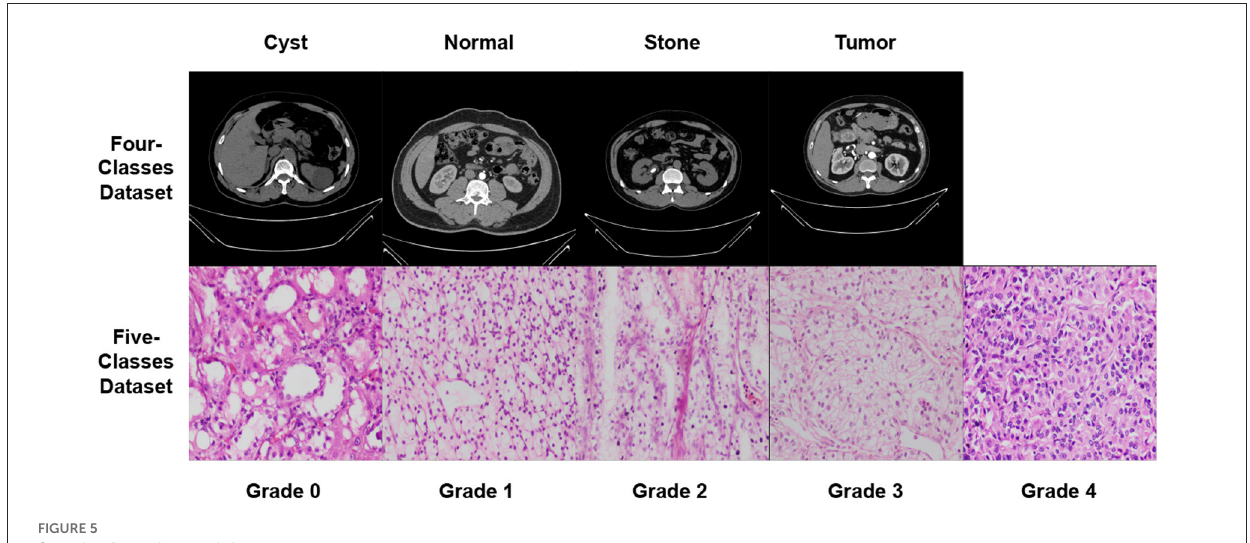
FIGURE5 Samples from the used datasets.